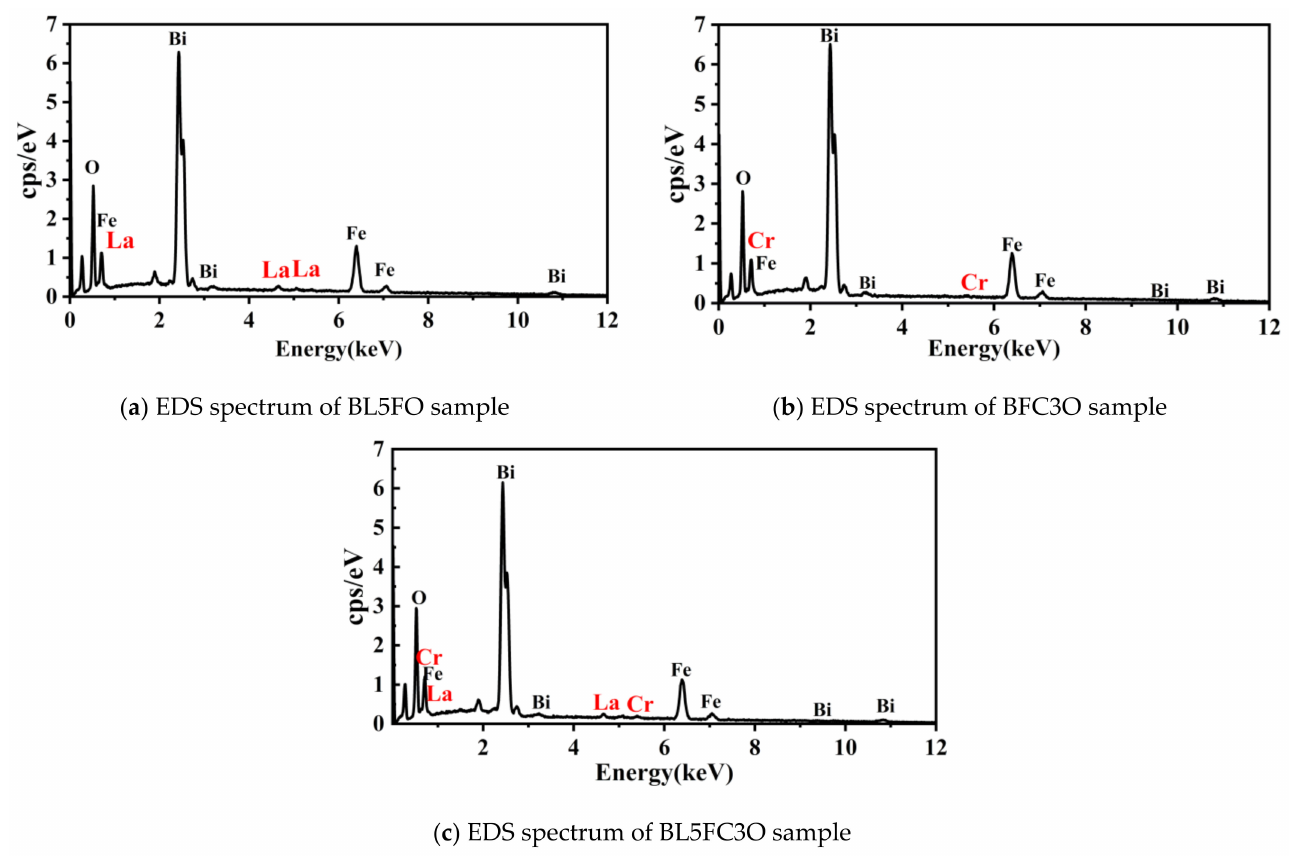
Figure 5. EDS spectrum of BFO sample doped with La and Cr. ( a ) EDS spectrum of BL5FO sample; ( b ) EDS spectrum of BFC3O sample; ( c ) EDS spectrum of BL5FC3O